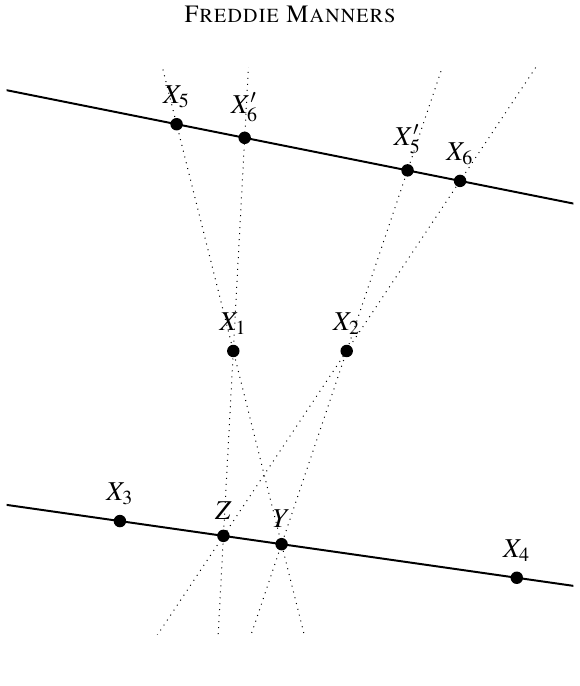
Figure 1: The block